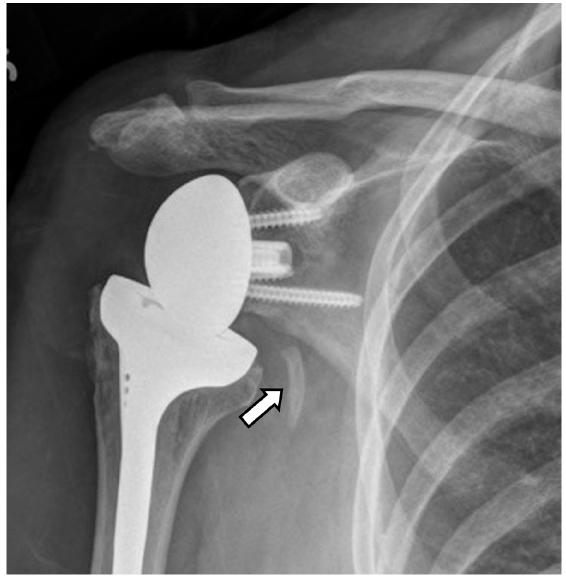
Figure 20. Frontal radiograph shows heterotopic ossi fi cation (arrow) along the proximal medial aspect of the humeral stem of an RTSA.